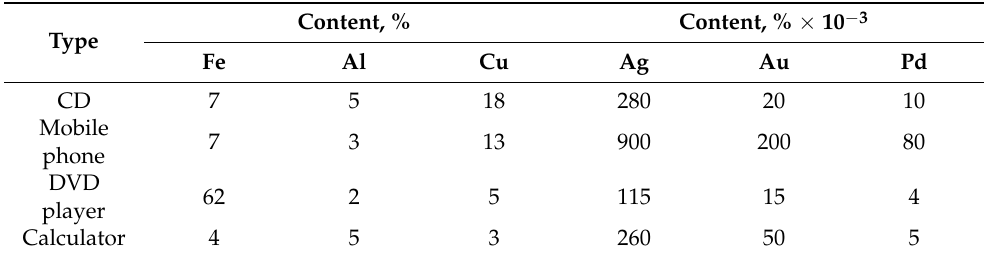
Table 1. Metal content in selected electronic devices, based on available online references [8].